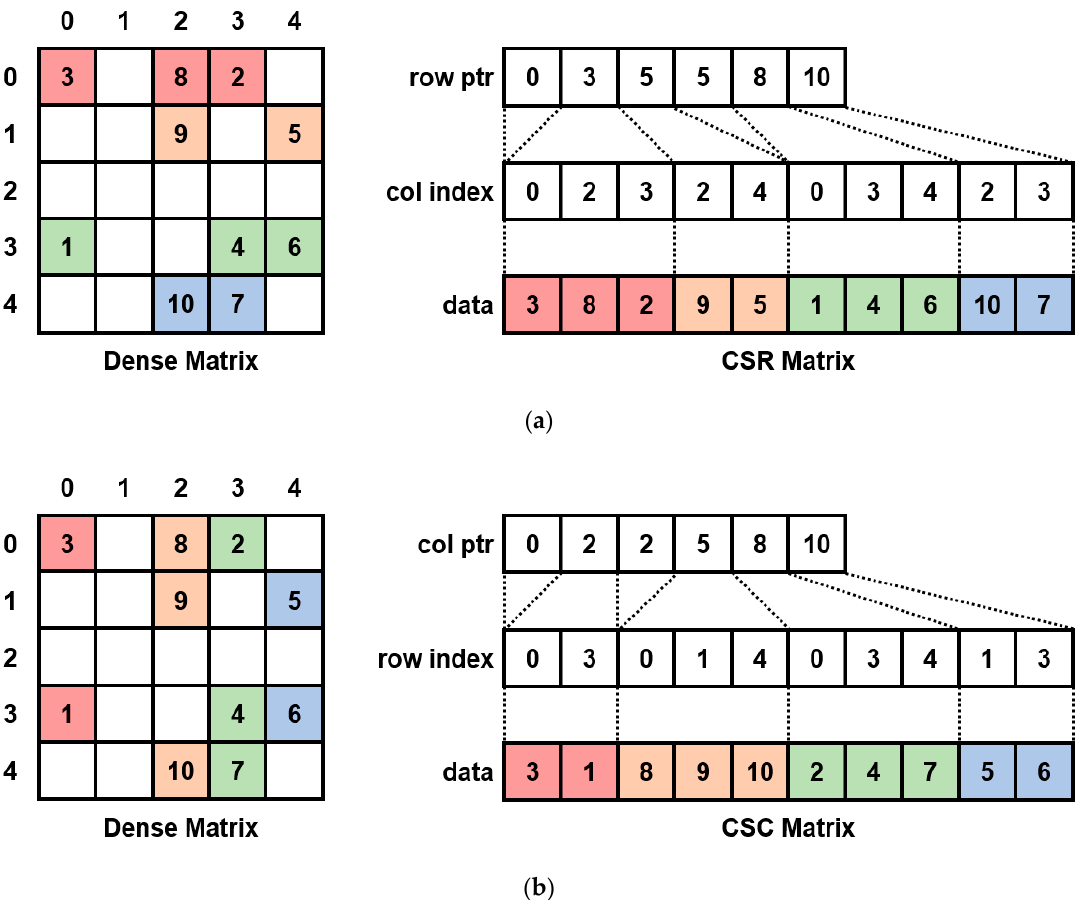
Figure 3. The examples of sparse-matrix conversions: ( a ) Dense to CSR conversion; ( b ) dense to CSC conversion.